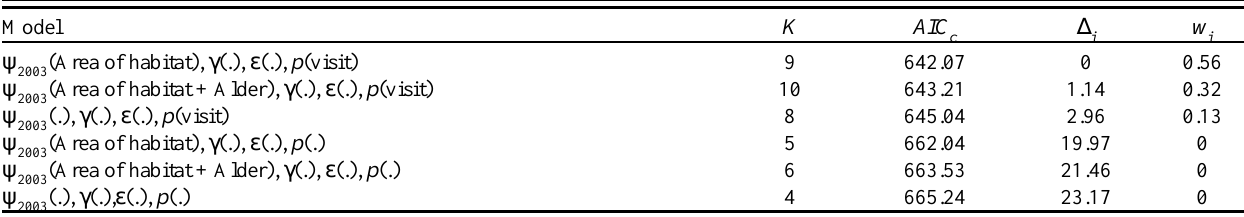
Table 1 . Comparison of multiseason models for habitat occupancy and detection probability of Wilson’s Warbler ( Cardellina pusilla ), based on 136 point-count stations at Forêt Montmorency, Québec, 2003-2004. Area of habitat (clear-cut or alder, Alnus spp.) was calculated within 400 m of point-count stations, Alder = alder scrubland (vs. clear-cut as reference habitat), g = probability of colonization, y = occupancy, e = probability of extinction, p(.) = fixed probability of detection, p(visit) = visit- and year-specific probability of